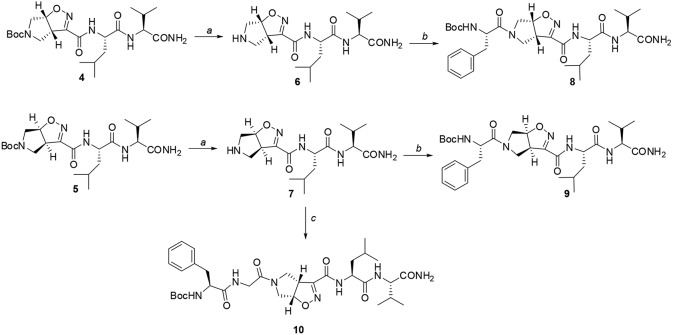
Reagents and conditions: a) TFA, CH2Cl2 from 0°C to r.t, 2 h; b) EDC/HOBt/DIEA, N-Boc-(L)-Phe, CH2Cl2 from 0°C to r.t, 24 h; c) EDC/HOBt/DIEA, N-Boc-(L)-Phe-Gly-OH, CH2Cl2 from 0°C to r.t, 24 h.